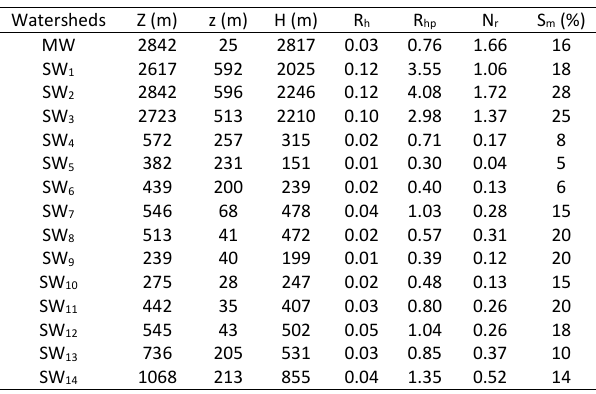
Fig. 2: Stream network of Muleta watershed Fig. 2. Stream network of Muleta Table 4: Geomorphometric values for relief parameters Table 4. Geomorphometric values for relief parameters